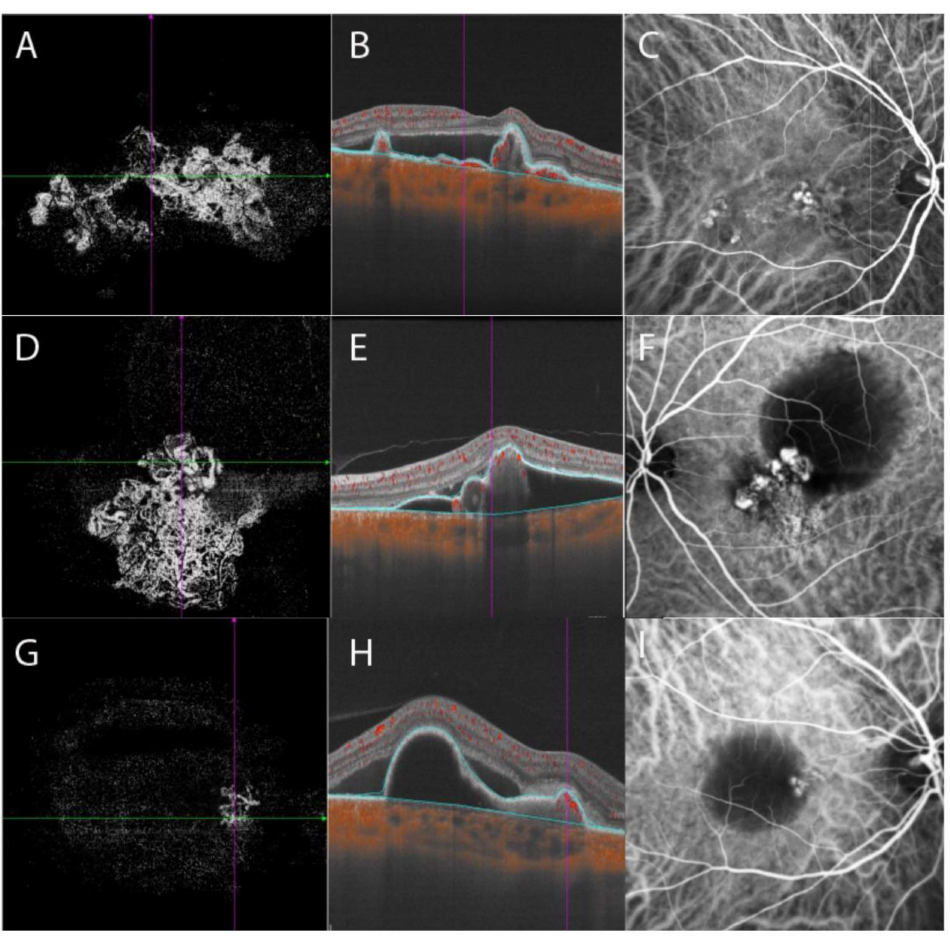
Figure 1. Three BNN subtypes were demonstrated with OCTA and ICGA. BNN morphologies within the PED layer were demonstrated in the left column. B‑scan OCTA images with blue lines delineating the PED layer were shown in the middle column. ICGA images were shown in the right column. En face OCTA of type 1 BNN, characterized by the presence of a major “trunk” or “stem”. The neovascular vessels radiated and spread toward the periphery area with tangled vessels forming polypoidal lesions at the edge of BNN ( A ). B‑scan OCTA showed peaked PED with internal flow sig‑ nals and subretinal fluid ( B ). ICGA showed multiple polypoidal lesions with a BNN ( C ). Type 2 BNN was featured by a cluster of interconnected neovascular vessels without a stem or trunk. Polypoidal lesions were embedded inside the BNN or at the edge of the branches of neovascular vessels ( D ). B‑scan OCTA showed PED with notches and internal flow signals ( E ). A cluster of polypoidal le‑ sions connected with BNN was shown on ICGA, accompanied by a hypofluorescent area represent‑ ing PED ( F ). Type 3 BNN had relatively smaller BNN on en face OCTA ( G ). B‑scan OCTA showed notched PED with internal flow signals and subretinal fluid ( H ). Polypoidal lesions with small BNN were shown on ICGA ( I ). BNN, branching neovascular network; OCTA, optical coherence tomogra‑ phy angiography; ICGA, indocyanine green angiography; PED, pigment epithelial